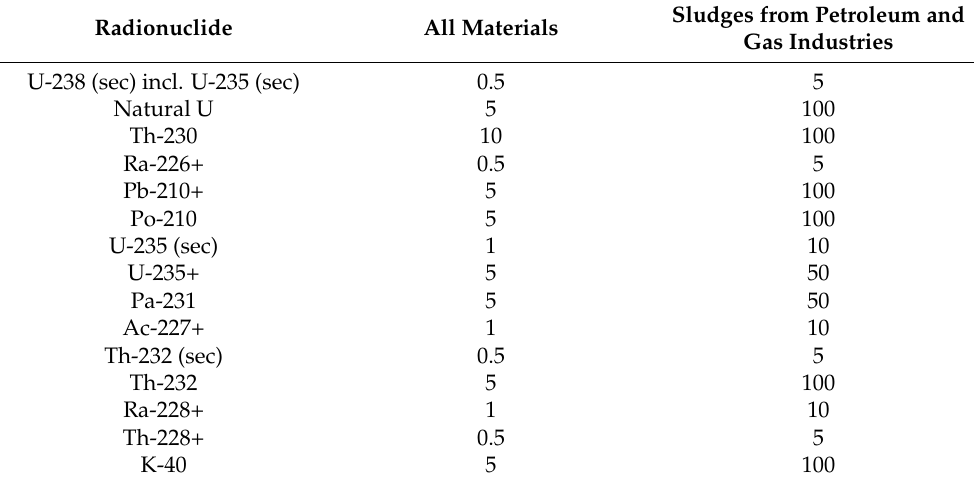
Table 1. Minimum activity concentrations (in kBq · kg − 1 ) of each radionuclide at which a sample can be considered a NORM, where two types of samples were taken into account: any material and the sludges from petroleum and gas industries. (sec): Radionuclide in secular equilibrium with all its daughters. (+): Radionuclide in secular equilibrium with its short-lived daughters. Sludges from Petroleum and Radionuclide All Materials Gas Industries U-238 (sec) incl. U-235 (sec) 0.5 5 Natural U 5 100